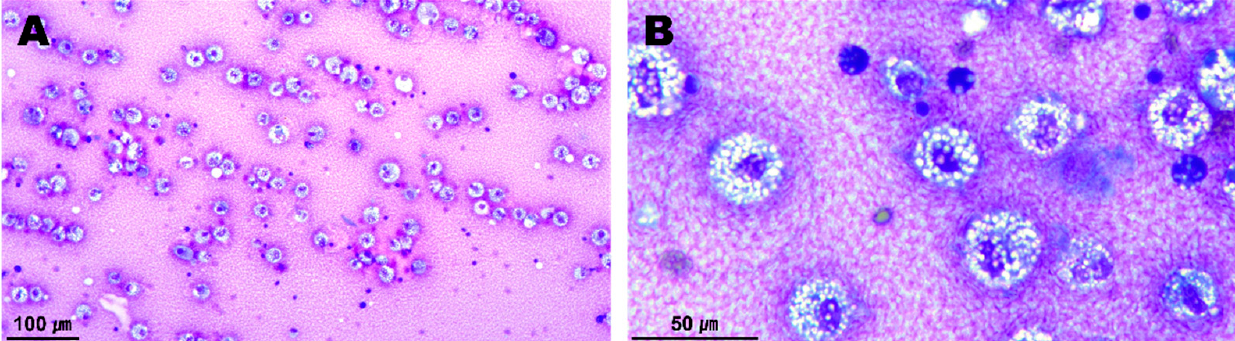
Figure 3. Cytology of the sampled pericardial fluid ( A , B ). A number of inflammatory cells appearing in the chronic inflammatory response were observed. Most of them were degenerative macrophages with vacuolated cytoplasms.